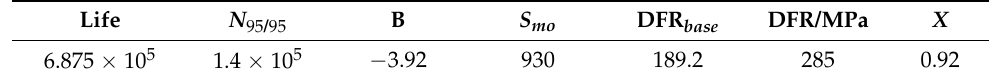
Table 5. Relevant Parameters Calculated